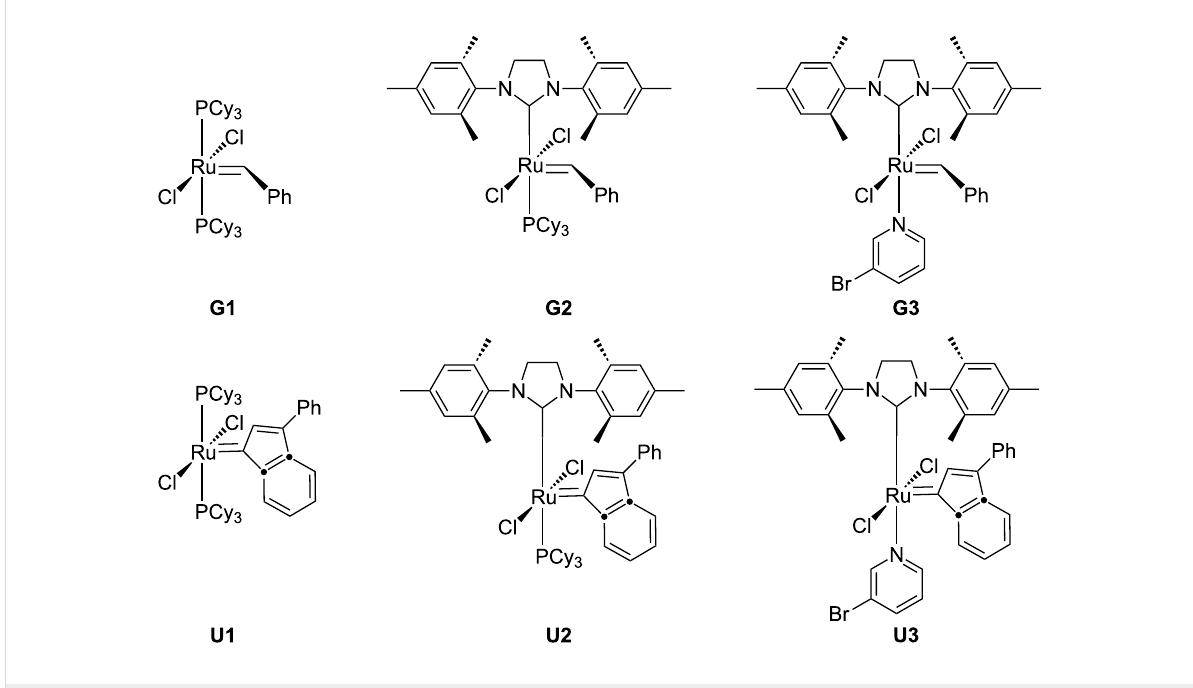
Scheme 1: Grubbs G1 – G3 and Umicore U1 – U3